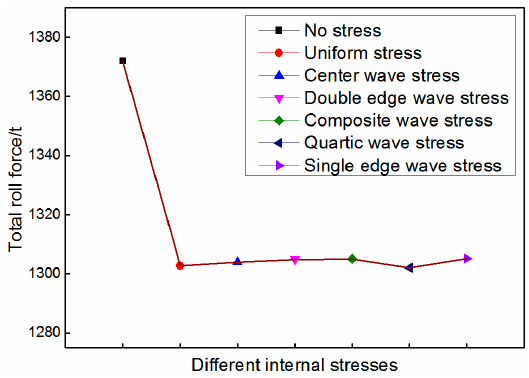
Figure 11. Total roll force under internal stresses with various distribution forms.